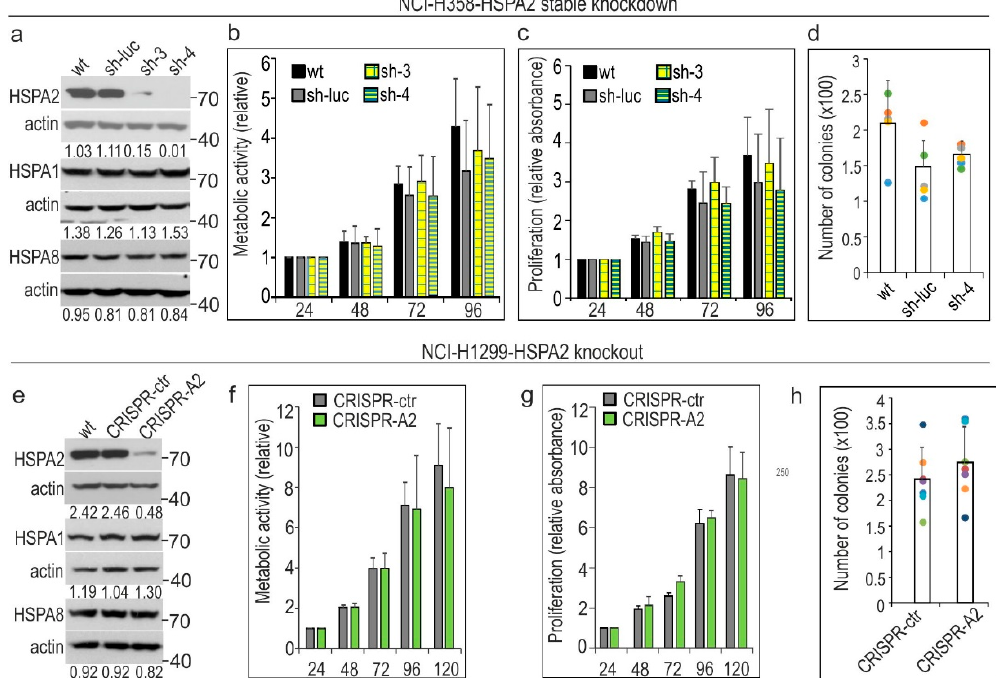
Figure 3. HSPA2 is dispensable for the growth of non-small cell lung carcinoma (NSCLC) cells. ( a–d ) E ff ects of stable HSPA2 knockdown on the growth of NCI-H358 cells. Control sh-luc cells were stably transduced with the non-targeting shRNA-luc sequence; sh-3 and sh-4 cells were stably transduced with the HSPA2 -targeting shRNA3 or shRNA4 sequences, respectively. ( e–h ) The HSPA2 gene knockout in NCI-H1299 cells did not a ff ect cell growth. CRISPR-A2, cells transfected with gene editing CRISPR / Cas9 plasmids; CRISPR-ctr, control cells transfected with negative control plasmid. Western blot analysis ( a , e ) of HSPA2, HSPA1, and HSPA8 levels in wild-type (wt) and modified cells. The numbers below each lane represent the protein ratio normalized to the actin level. Representative immunoblots are shown ( n = 4; molecular weight in kDa is indicated), actin was used as a protein loading control. Cell metabolic activity ( b , f ) was measured using the MTS assay. Cell proliferation rate ( c , g ) was examined using crystal violet staining assay ( n = 3; each in three technical replicas). Cell metabolic activity and cell proliferation rate are expressed as mean ± SD ( n = 3, each in three technical replicas) in relation to values obtained at 24 h after plating. To analyze the clonogenic ability ( d , h ) cells were plated onto six-well dishes (1 × 10 3 cells / well for NCI-H1299 and 3 × 10 3 cells / well for NCI-H358 cell line) and cultured for 7 days (NCI-H1299) or 11 days (NCI-H358). Colonies were counted manually (mean ± SD, NCI-H1299 n = 7, each in three technical replicas; NCI-H358 n = 5, each in 2–3 technical replicas). Each dot color represents results of one of five ( d ) or seven ( h ) independent experiments.